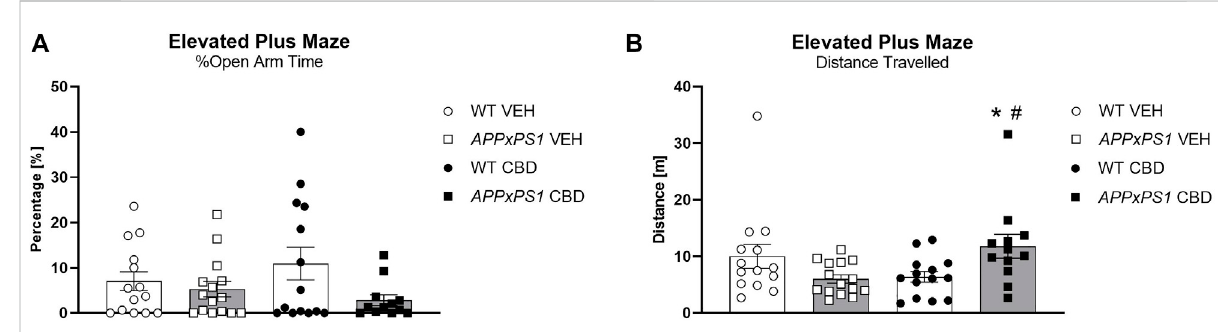
FIGURE 4 Increased locomotion but unaltered anxiety-like behaviour in APPxPS1 mice in the elevated plus maze test, following long-term CBD. (A) Distance travelled [m] and (B) percentage of open arm time [%] in the elevated plus maze test in APPxPS1 and WT mice treated daily with 20 mg/kg CBD for 8 months. A main effect of “ genotype ” ( p = 0.04) was detected in (A) . A “ genotype ” x “ treatment ” interaction ( p = 0.004) was detected in (B) . Data were analysed using two-way RM ANOVA and presented as mean ± SEM. When data were split by the corresponding factor, signi fi cant “ genotype ” effects in CBD-treated mice are indicated by asterisks (* p < 0.05, vs. WT CBD), and signi fi cant “ treatment ” effects in APPxPS1 mice are indicatedbyhashsymbols( # p < 0.05, vs. APPxPS1 VEH).N=14WTVEH, 15 APPxPS1 VEH, 14WTCBD, and12 APPxPS1 CBD. Abbreviations: APPxPS1